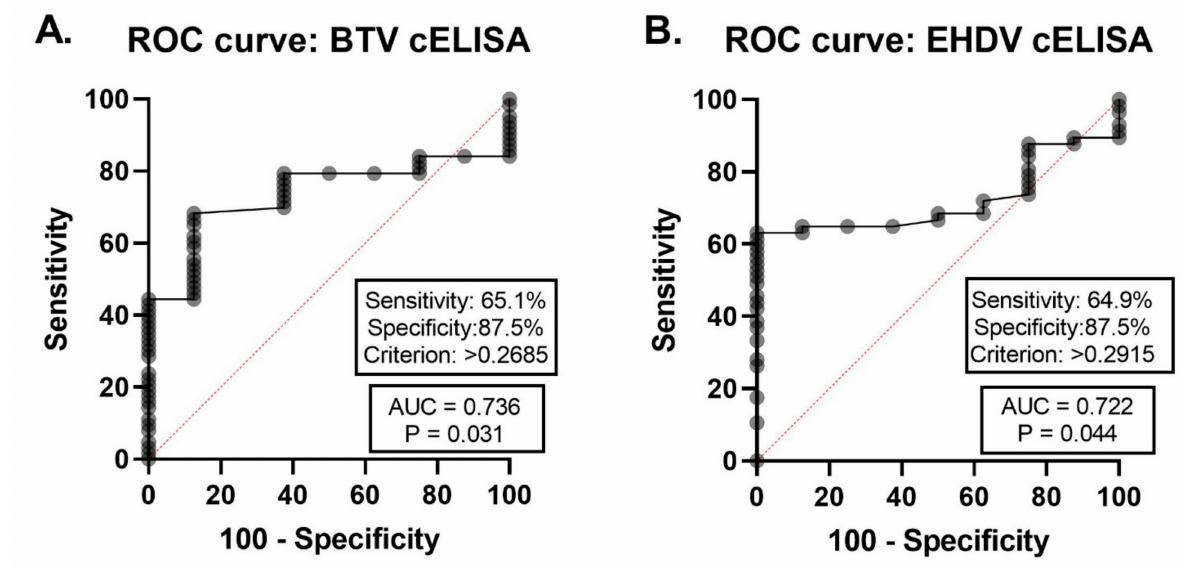
Figure 6. Receiver operating characteristic (ROC) curve showing the performance of the commercial BTV and EHDV cELISA kits for 89 field-collected cattle serum samples. ( A ) The area under the curve (AUC) reported an acceptable relationship [51] of 0.736 ( p = 0.031) between the BTV cELISA kit (IDEXX) and its controls. ( B ) The AUC reported an acceptable relationship of 0.722 ( p = 0.044) between the EHDV cELISA (ID Vet) and its controls. ROC curves were based on absorbance of samples compared to kit controls. Sensitivity, specificity, and criterion results as